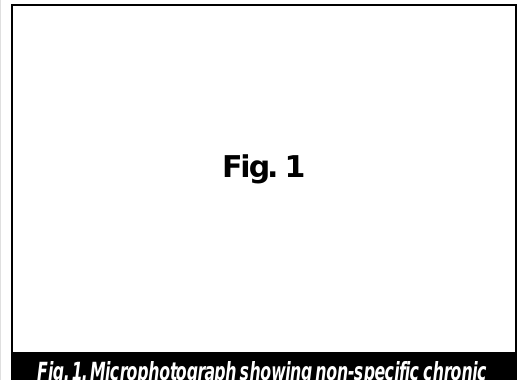
Fig. 1. Microphotograph showing non-specific chronic granulomatour inflammation of urinary bladder (H&E, 5X)